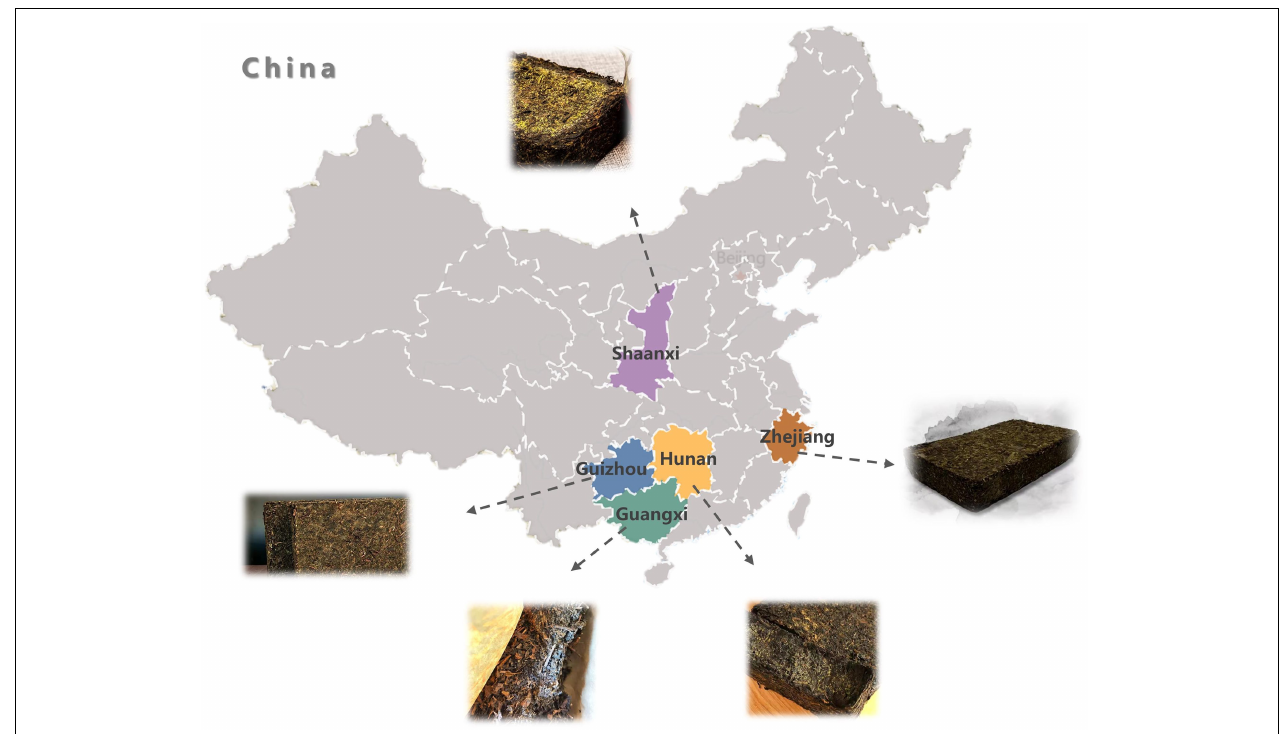
FIGURE 1 | The five Fu brick teas were collected from different provinces of